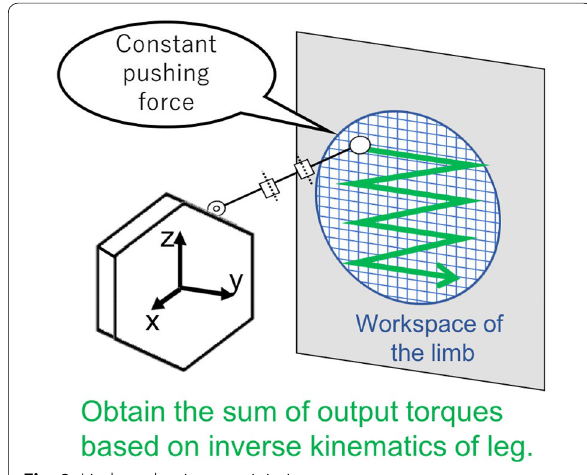
Fig. 9 Limb evaluation to minimize output torque